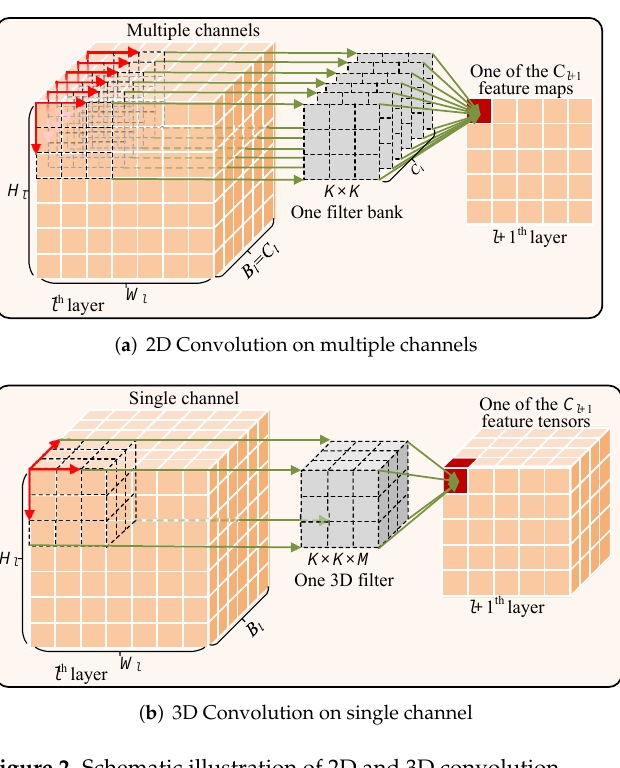
Figure 2. Schematic illustration of 2D and 3D convolution.